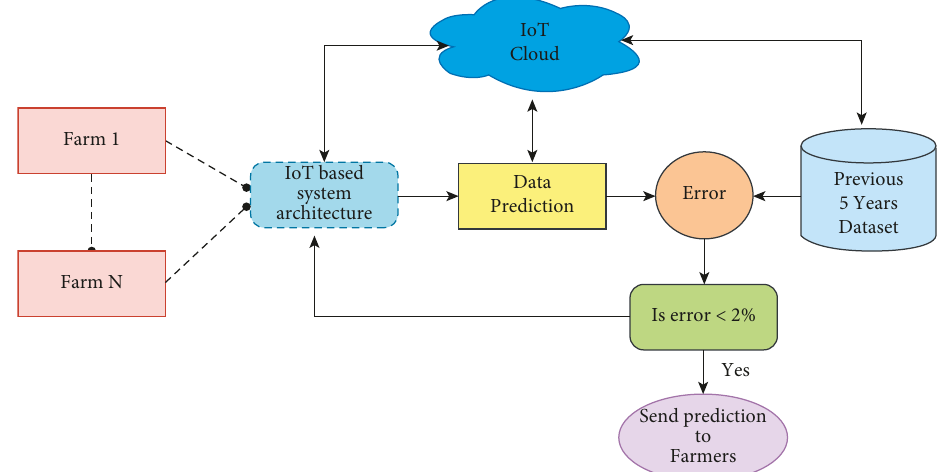
Figure 2: User interface network using IoT.